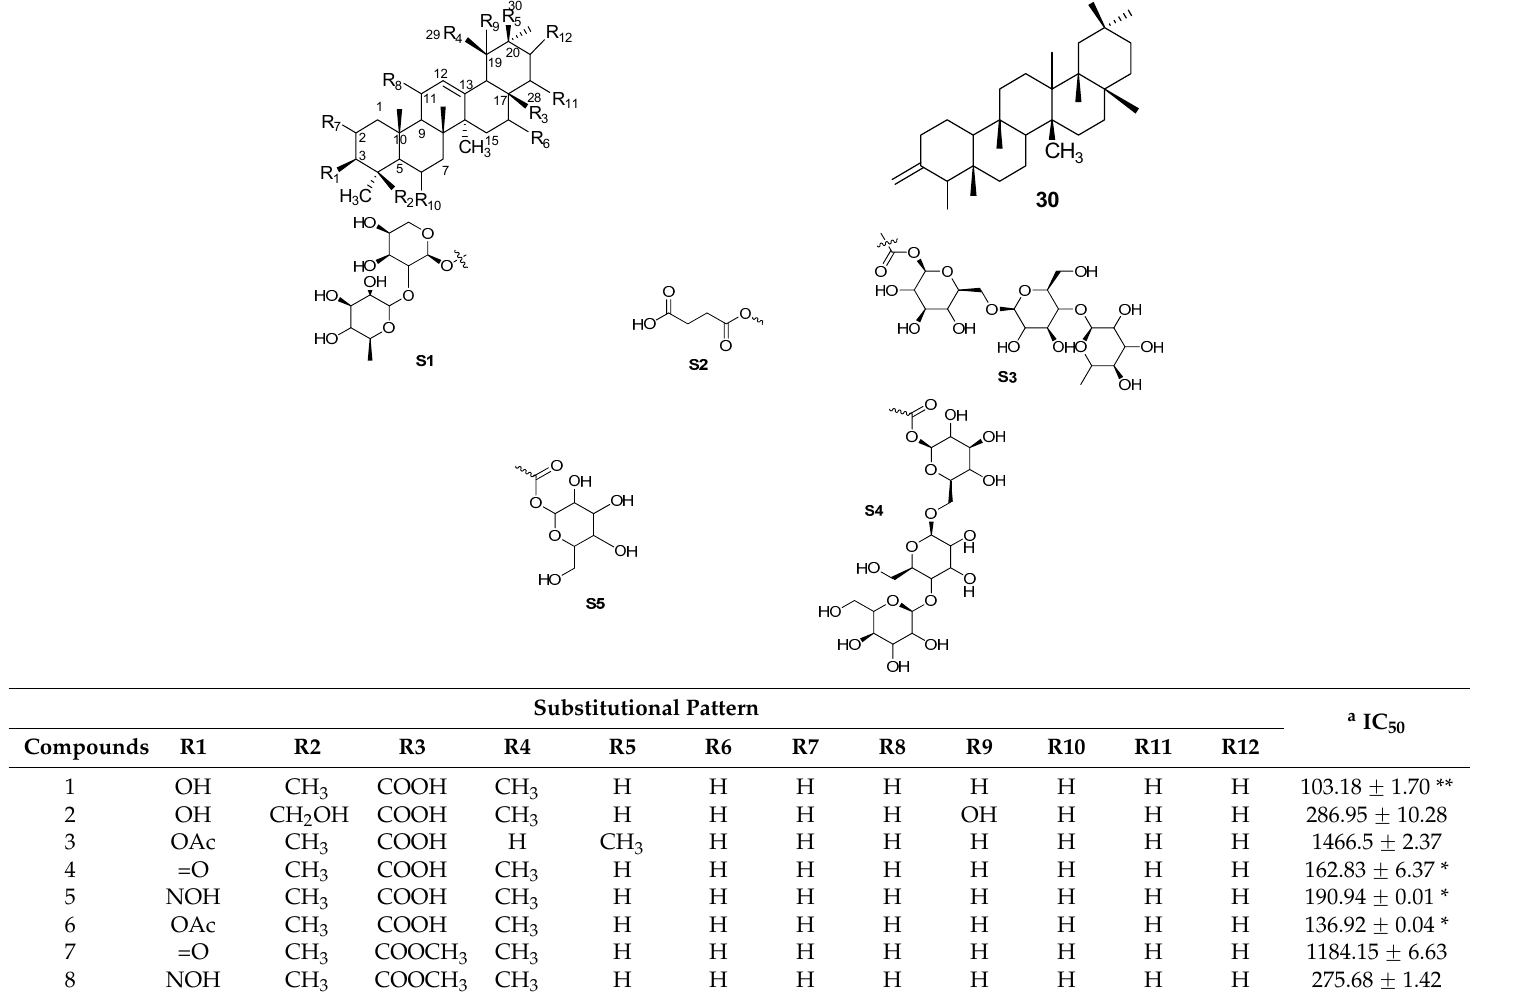
Int. J. Mol. Sci. 2016 , 17 , 143 Table 1. Hyaluronidase inhibitory activity of ursolic acid 1 and its analogues at the concentration of 100–2000 µ M.